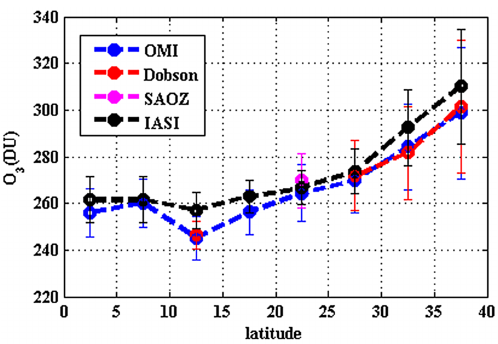
Figure 6. Latitudinal distribution of TCO and its associated stan- dard deviation observed for each